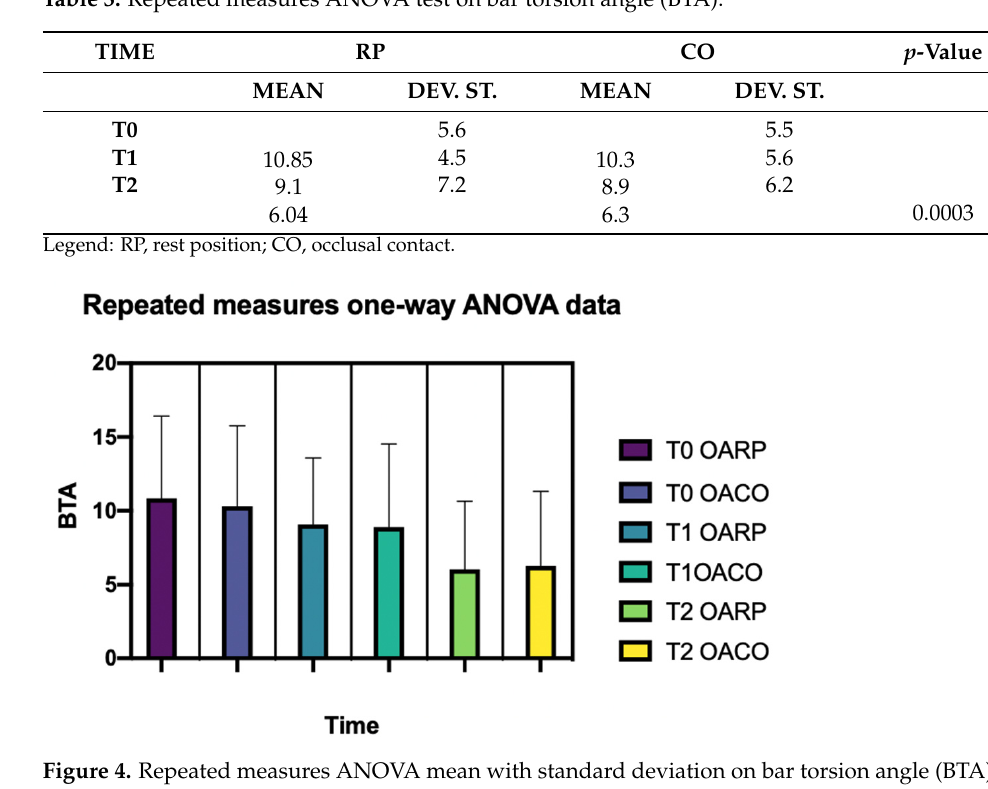
Table 4. Tukey’s multiple comparisons of the repeated measures ANOVA test on BTA .